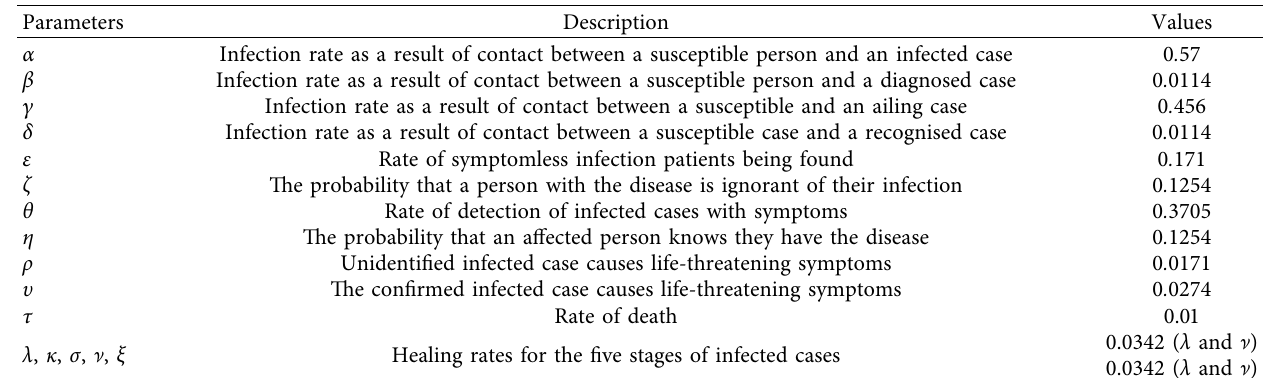
Table 1: SIDARTHE epidemic model transmission